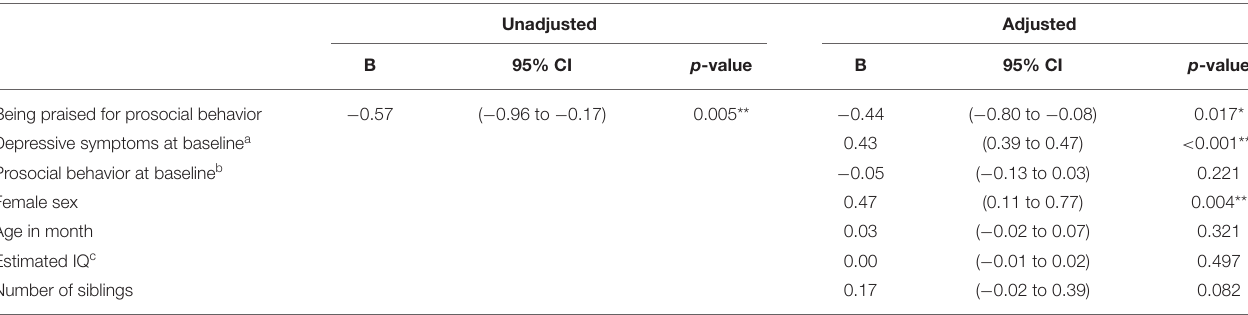
TABLE 2 | The association between being praised for prosocial behaviors at age 10 and depressive symptoms at age 12.